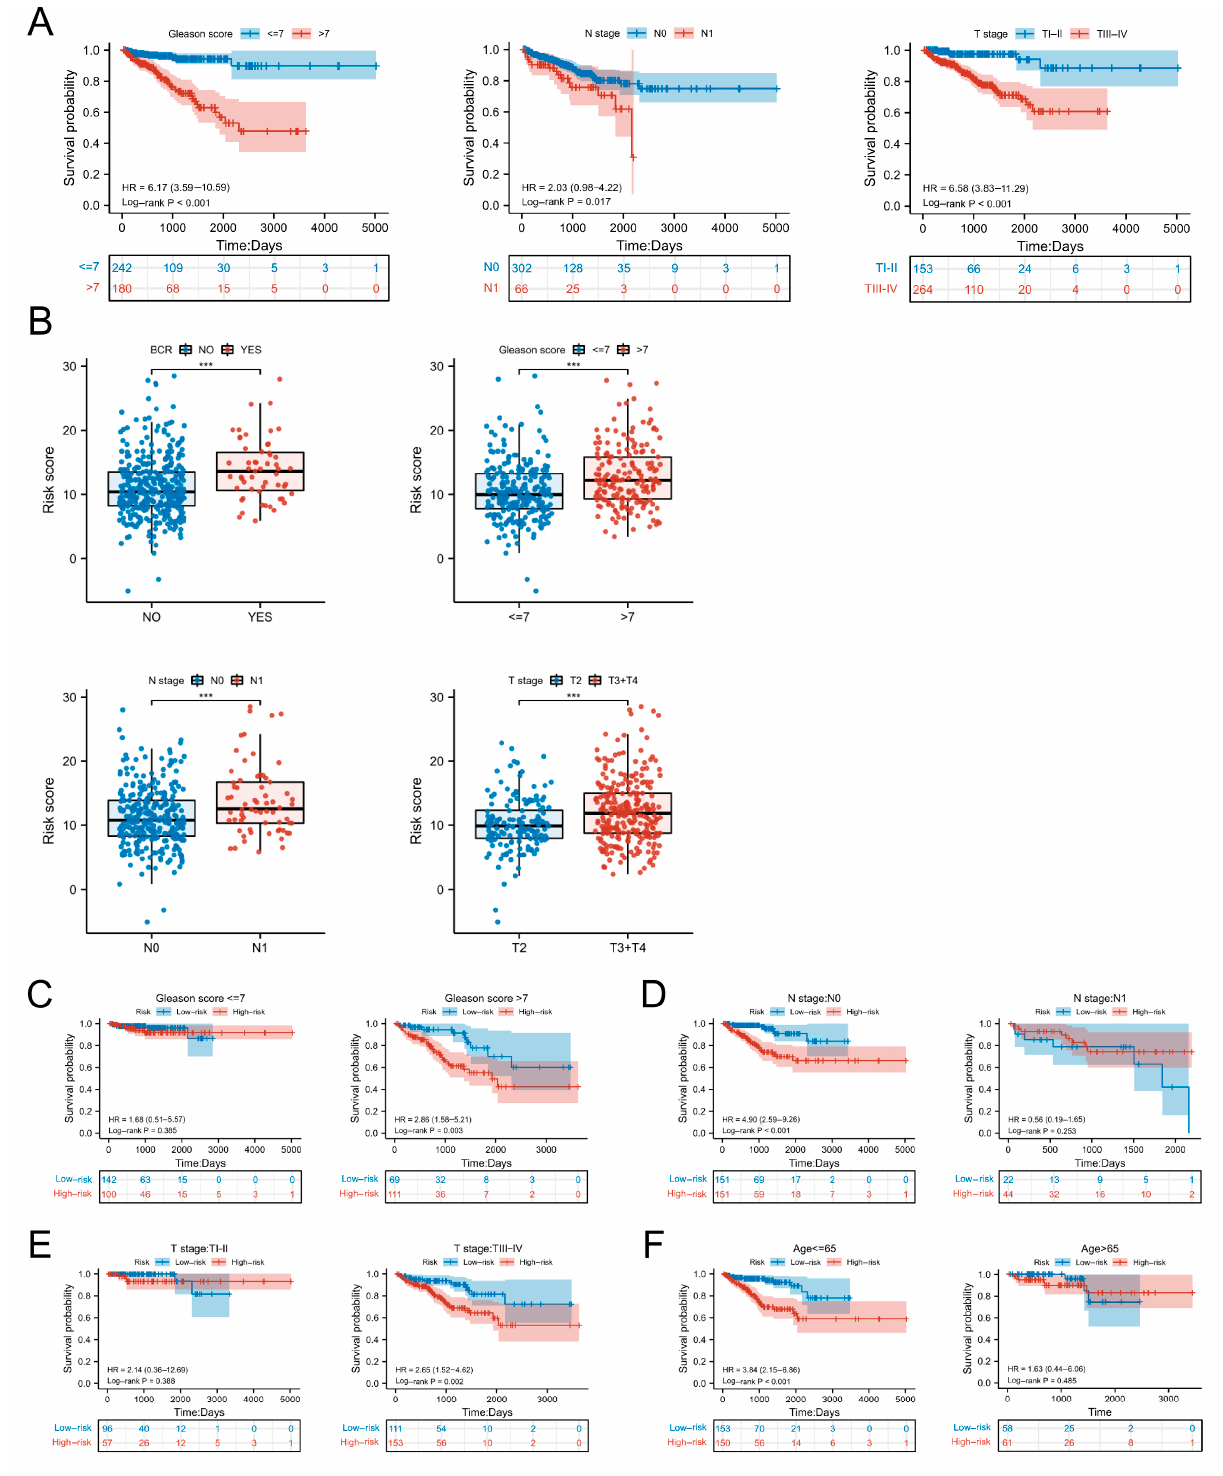
Figure 3. BCRFS analysis in different clinical characteristics. ( A ) BCRFS analysis in different patho- logical conditions. ( B ) Risk score difference in different pathological conditions. ( C ) BCRFS analysis in Gleason score > 7 and Gleason score ≤ 7. ( D ) BCRFS analysis in N0 stage and N1 stage. ( E ) BCRFS analysis in TI-II stage and TIII-IV stage. ( F ) BCRFS analysis in age > 65 and age ≤ 65. *** p <